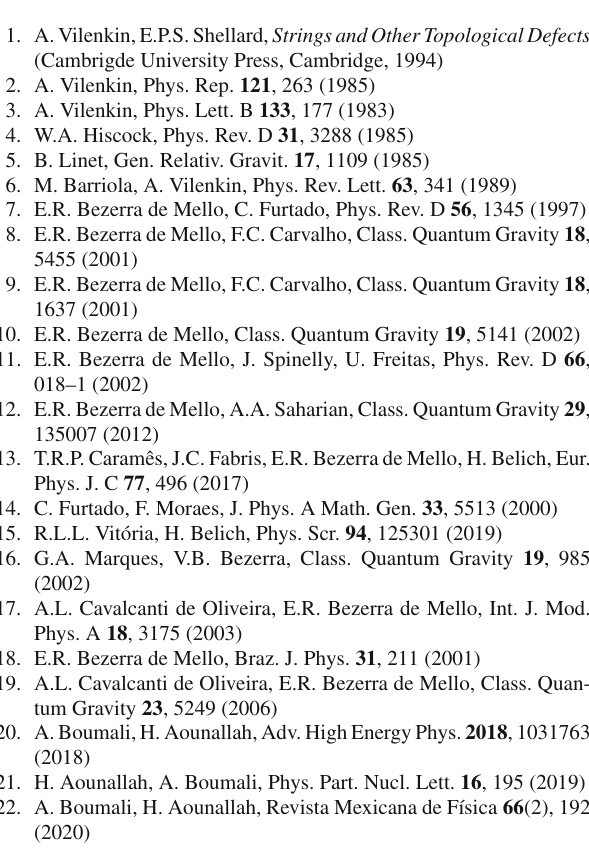
Fig. 3 Behavior of negative.Forthisillustrationwetake α = 0 . 5inthecase(i)and α = 0 .